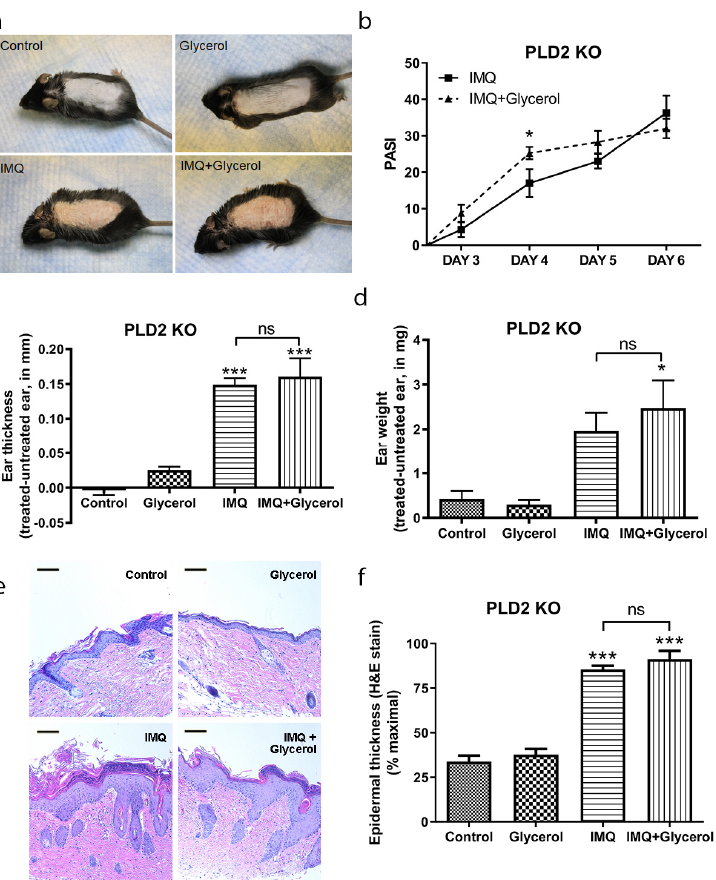
Figure 4. Oral glycerol does not improve IMQ-induced psoriasiform lesions in PLD2 knockout mice. PLD2 knockout mice receiving glycerol (2%) in drinking water or not were treated with vehicle or IMQ daily for 5 days. ( a ) Representative photographs (day 6) showing effects on epidermal erythema and scaling with treatments. ( b ) Psoriasis area severity index (PASI) scores were quantified and analyzed by unpaired, two-tailed t-tests comparing two groups within the same day. ( c ) Ear thickness and ( d ) ear weight measured as described in Methods. ( e ) Representative H&E-stained micrographs showing back skin epidermal thickening with IMQ treatment (scale bar = 100 µ m). ( f ) Quantitation